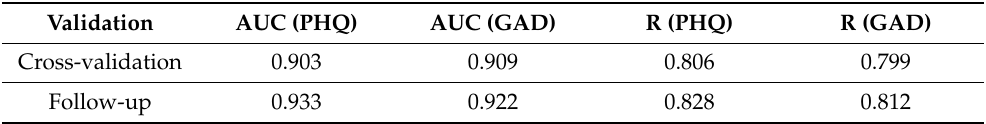
Table 2. AUC and R scores for language modality comparing initial cross-validated scores with the follow up